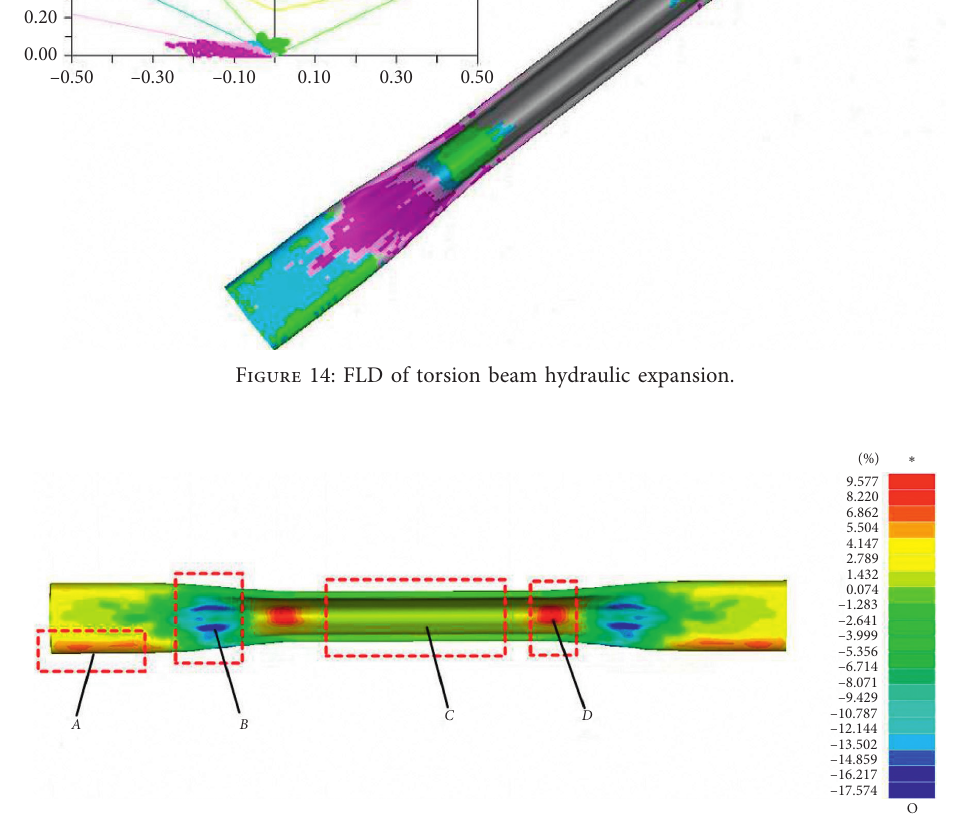
Figure 15: Nephogram of torsion beam hydraulic bulging wall thinning rate. Table 2: Level factor setting